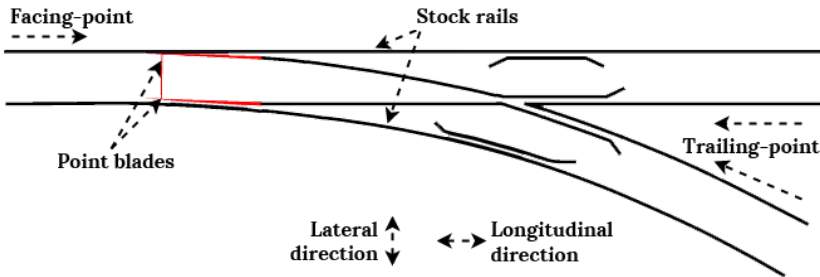
Figure 1. Diagram of simple turnout showing its principal parts. Moving switch blades are shown in